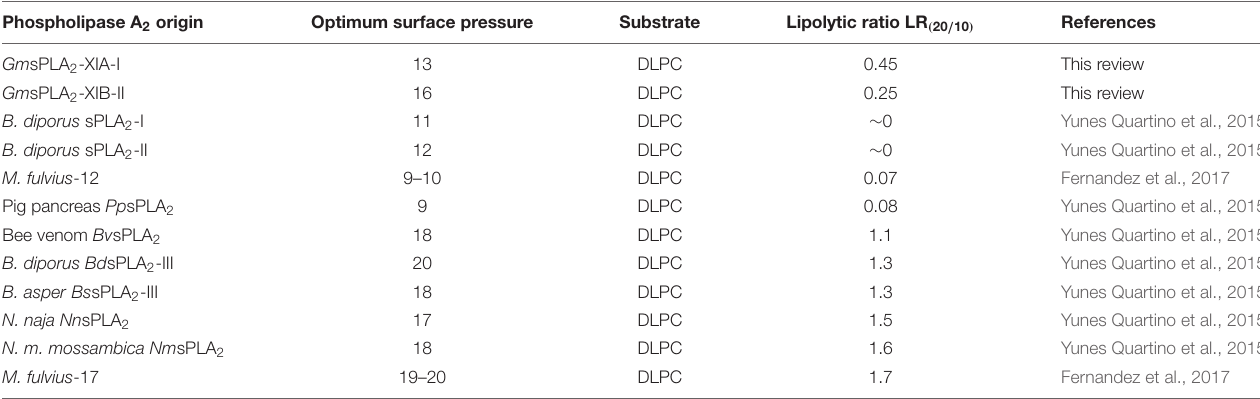
TABLE 10 | Parameters determined for different sPLA 2 s using monomolecular films of